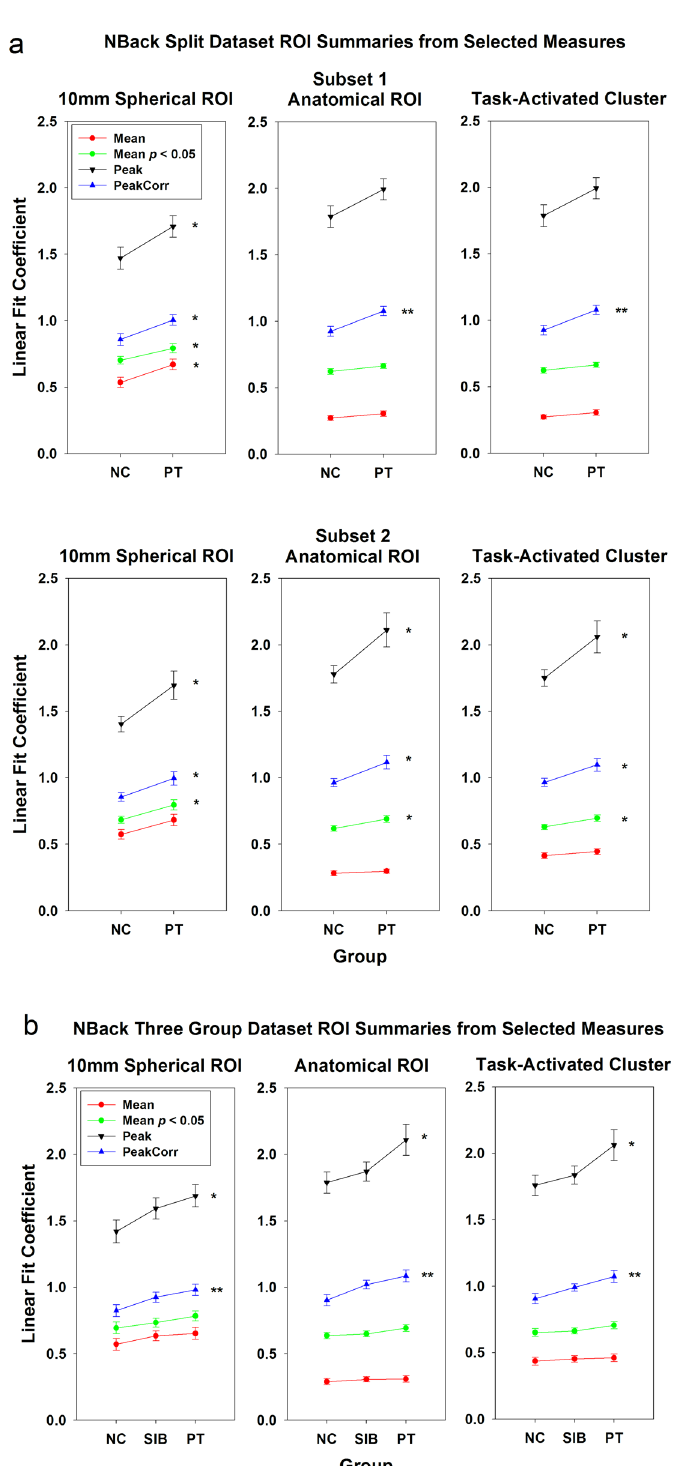
Fig 3. Group mean plots for two NBack datasets. (a) The split dataset PTs vs. NCs; and (b) the Sibling dataset, PTs vs. SIBs vs. NCs. Selected ROI summary measures (mean, mean of voxels above p = 0.05 threshold, peak, and peak-correlated voxels) were used to extract single-value summaries from three types of ROIs in right DLPFC. * p < 0.05; ** p < 0.01. Error bars represent standard errors.